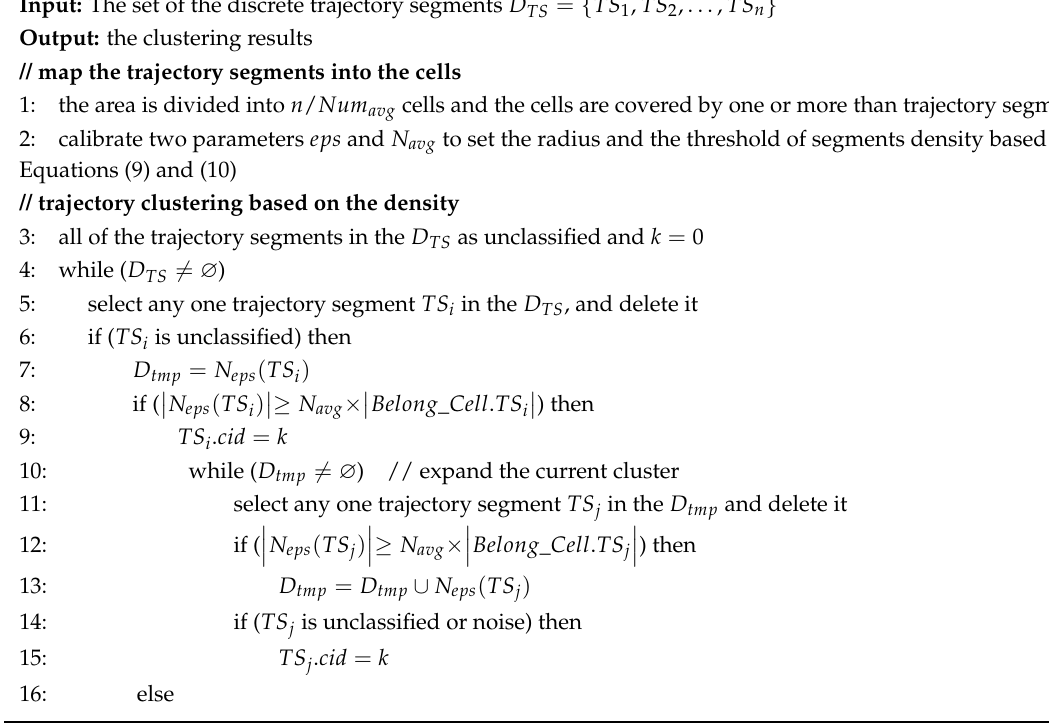
Algorithm 2. The Density-Based Trajectory Clustering